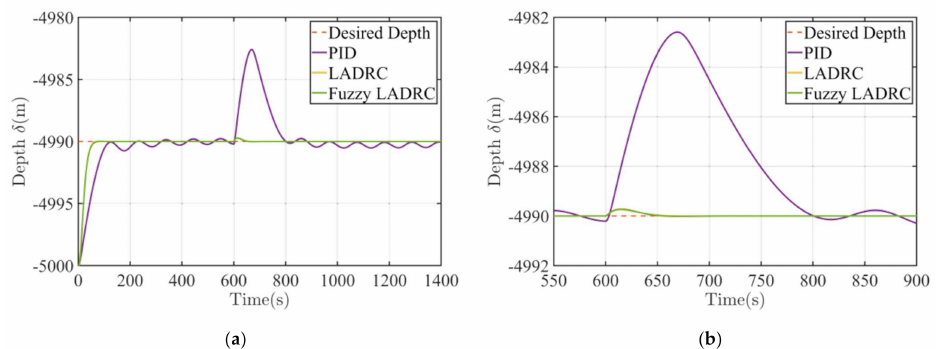
Figure 8. Control response curves of the AUV system with step disturbance force. ( a ) Depth response curves of different controllers. ( b ) Magnified view of depth response